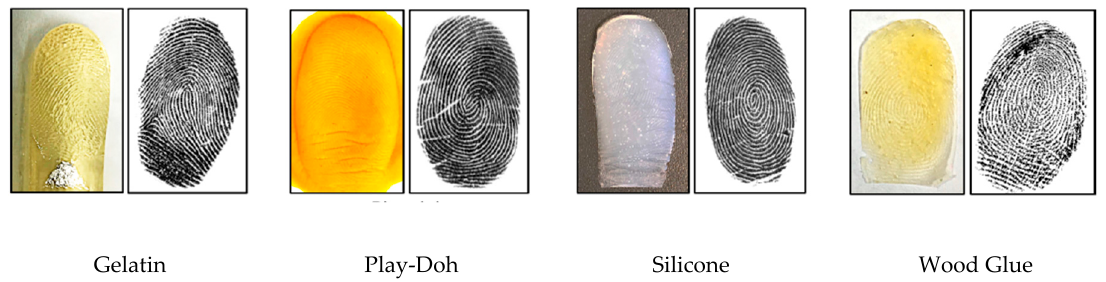
Figure 1. Examples of fingerprint artefacts fabricated using different materials. A real image of a fabricated fingerprint is shown on the left and a scanned image using a fingerprint sensor is shown on the right [4].